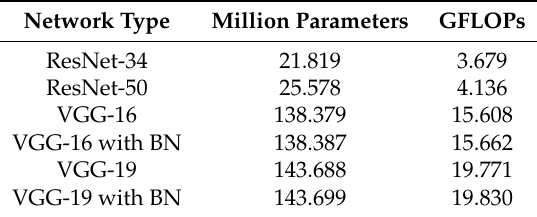
Table 3. Comparison of various network